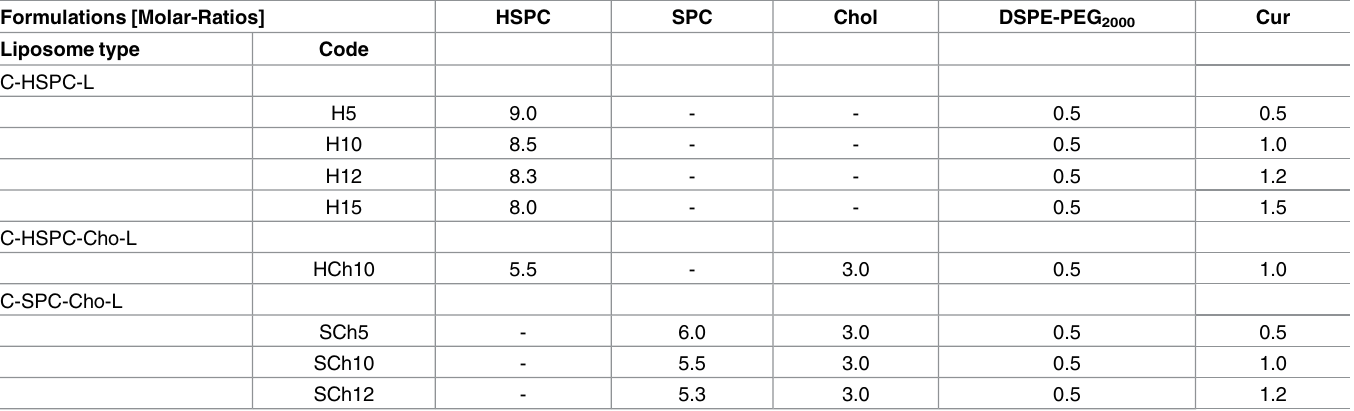
Table 1. Liposome compositions used in the study. Formulations